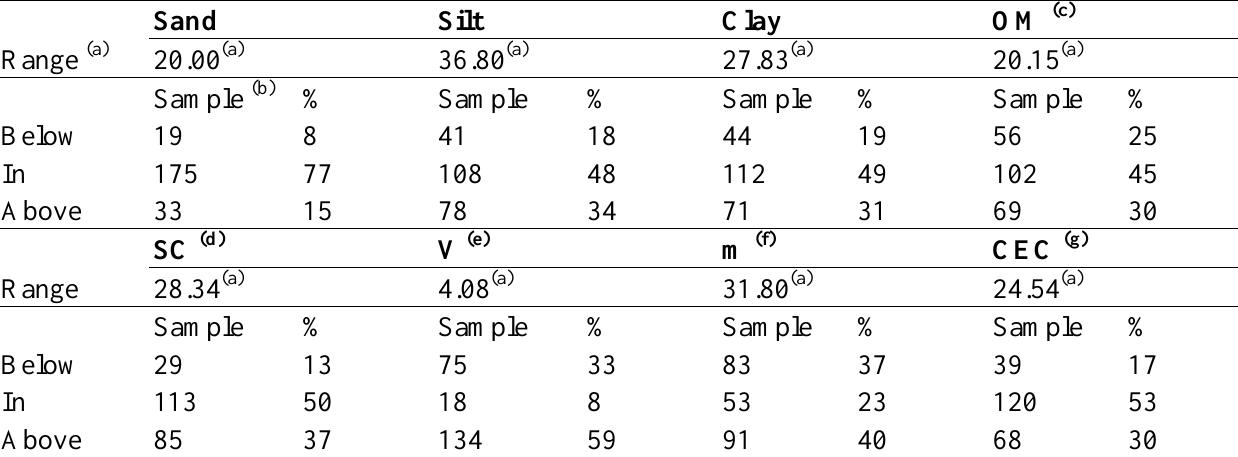
Table 7. Number of samples that used multiple regression equations spectral models (satellite spectral data) to determine soil attribute